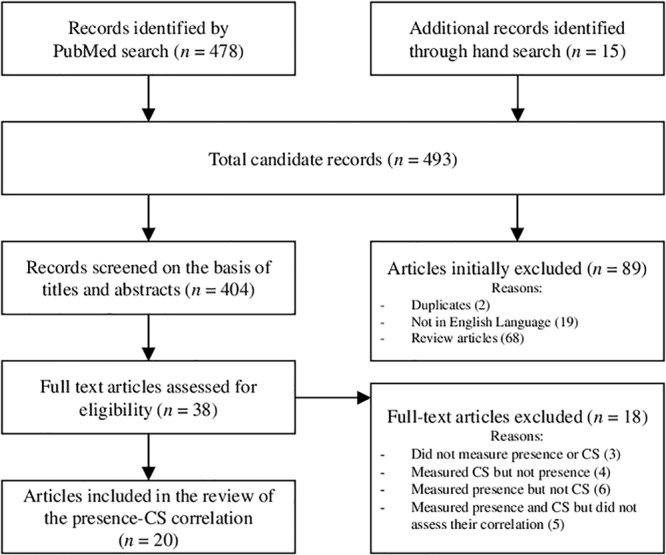
PRISMA flowchart indicating the method for identifying and selecting articles that depict the relationship between presence and CS. Based on Moher et al. (2009).